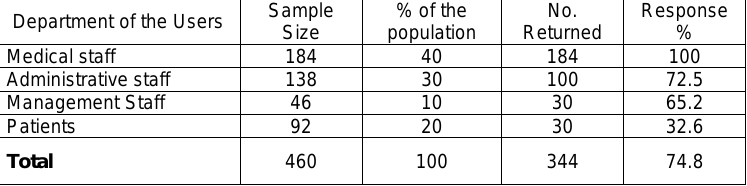
Table 5: Ranking of the levels of use of selected project plans